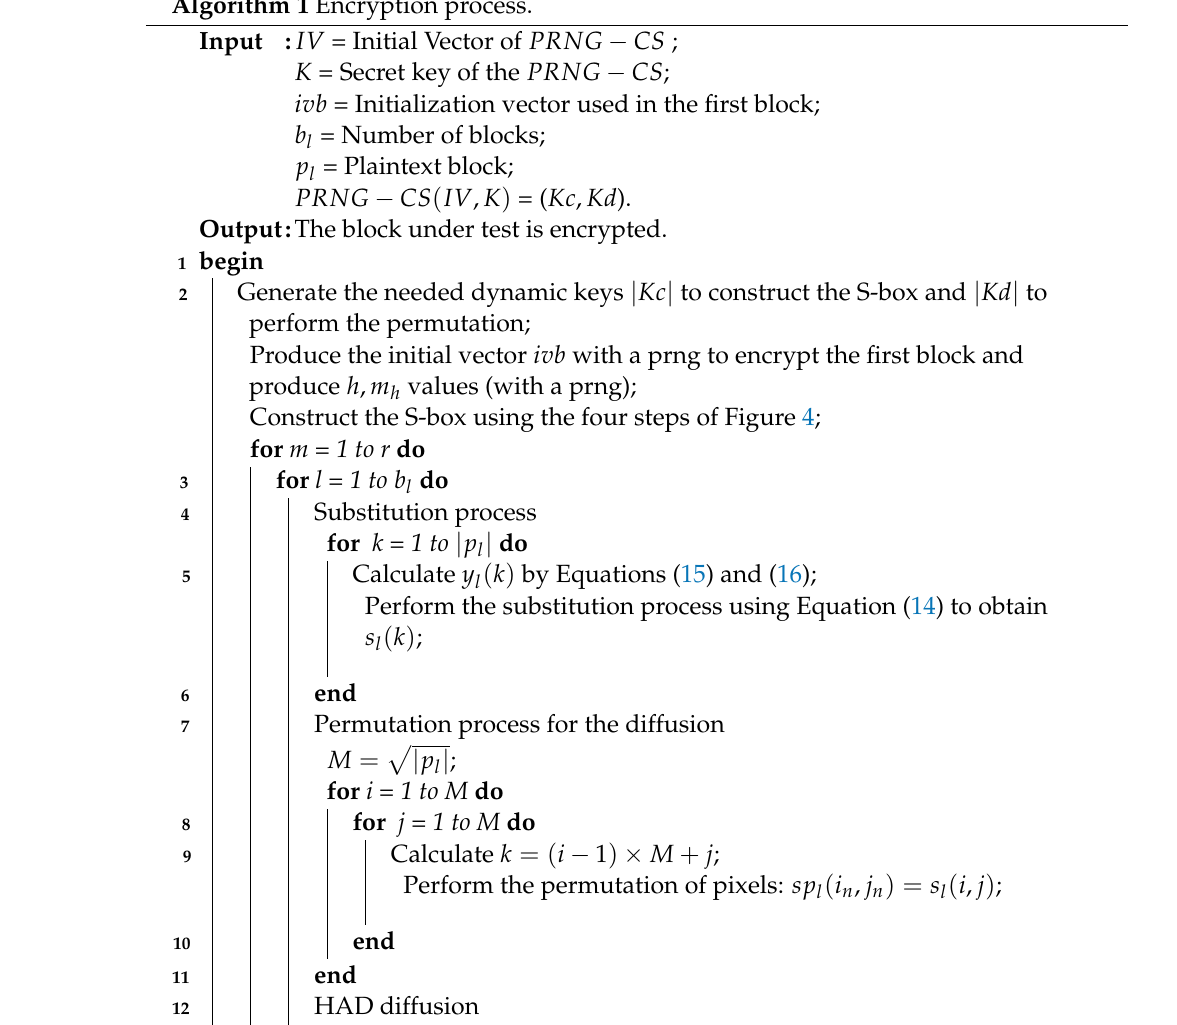
Algorithm 1 Encryption